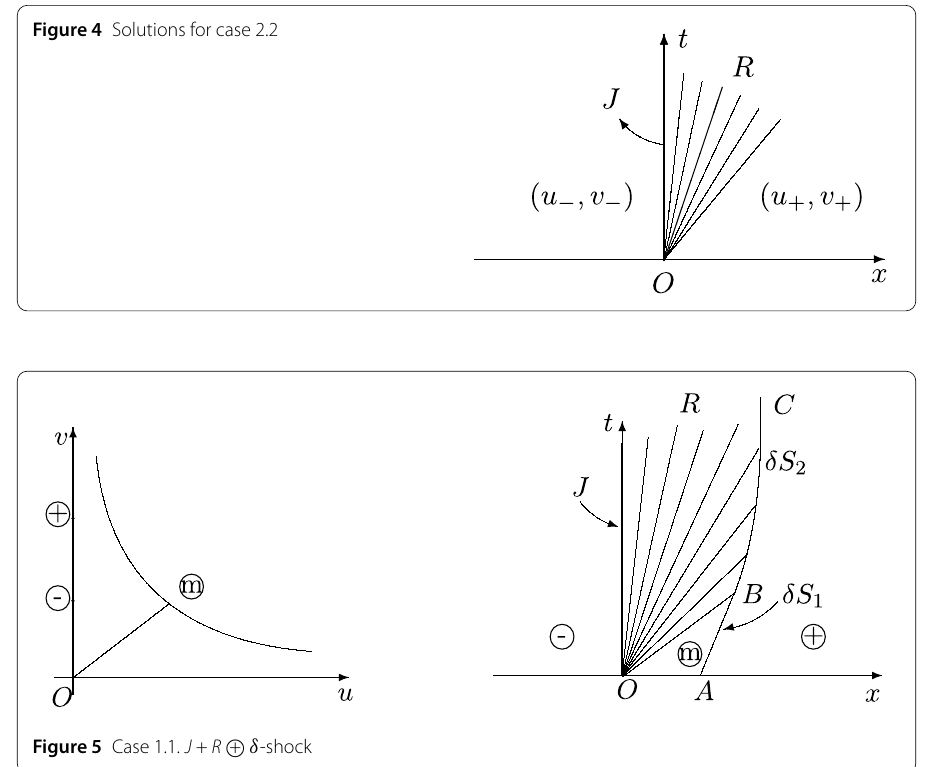
Figure 4 Solutions for case 2.2